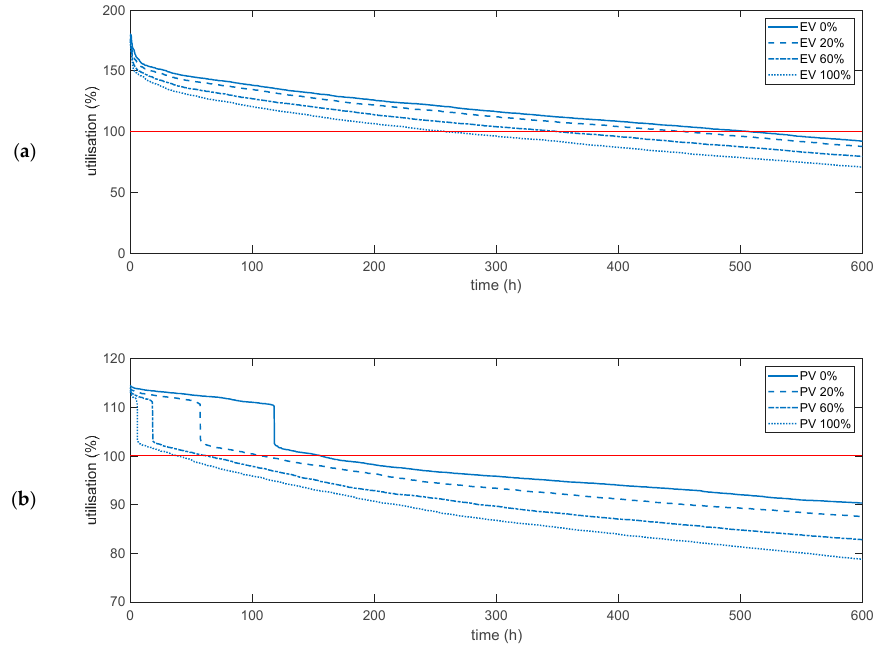
Figure 14. Annual duration curve of the utilisation for the period 0 to 600 h for 3.7 kW charging power and charging strategy 1 ( a ) line 1 and a fixed penetration of 60% PV ( b ) line 5 and a fixed penetration of 60% EV.